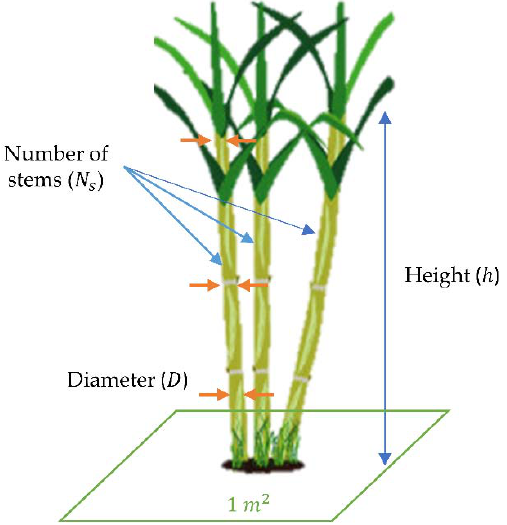
Figure 2. Representation of biometric parameters in a sugarcane plant. A stem with medium height is selected in this 1 m 2 area as a representative from which the height h (m) and the diameters at the base, middle, and top of the stem can be measured. The final diameter D (m) is obtained by averaging those three measurements. A model with a Spearman’s correlation of 0.95 [43] is then employed to calculate the measured AGB by biometric parameters 𝐴𝐺𝐵 (cid:3040) , 𝐴𝐺𝐵 (cid:3040) = 𝜋 𝐷 (cid:2870) 4 ℎ × 𝑁 (cid:3046) × 𝜌 × 0.977 𝑑 (cid:3051) , (1) where 𝑑 (cid:3051) (m) is the space between crop lines; destructive analysis was performed in a few stems to calculate the stem density 𝜌 (kg m − 3 ). The sugarcane harvesting was carried out on 1 July 2020, when all the plants were weighed to calculate the harvested AGB. Measured AGB obtained from Equation (1) was used as reference data to develop the proposed AGB estimation method. Sugarcane biometric measurements were collected from 19 December 2019 to 12 May 2020. The campaigns of 1 and 17 June 2020 were not considered for biometric measurements due to a lodging problem in the experimental area. 2.2.3. Ripening Index Measurement The ideal harvesting date for sugarcane crop can be defined as the day on which the plantation reaches its maximum metabolization of soluble solids, measured on a °Brix scale. A destructive analysis is necessary to determine the RI, which is defined as the ratio of the metabolization of soluble solids measured at the top and at the node close to the ground level. Sugarcane reaches its ideal cut-off point when 0.85 < RI < 1.00 [6]. The sugarcane RI in the experimental area was evaluated using a manual refractometer in a few plants to establish the appropriate harvesting date based on the Brix ratio obtained in the last node at the top and in the fourth node above the ground level [44]. Figure 3 presents the sugarcane RI and measured AGB from the experimental area, and an AGB curve obtained from the interpolation of measured AGB values. From the values shown in Figure 3, it is possible to infer that the sugarcane crop reaches the maximum AGB on day 280. From this point on, the sugarcane plants begin to metabolize sugars, reaching and stabilizing at the maximum RI on day 360, approximately 80 days after the maximum AGB, when the optimal harvesting date is accomplished.